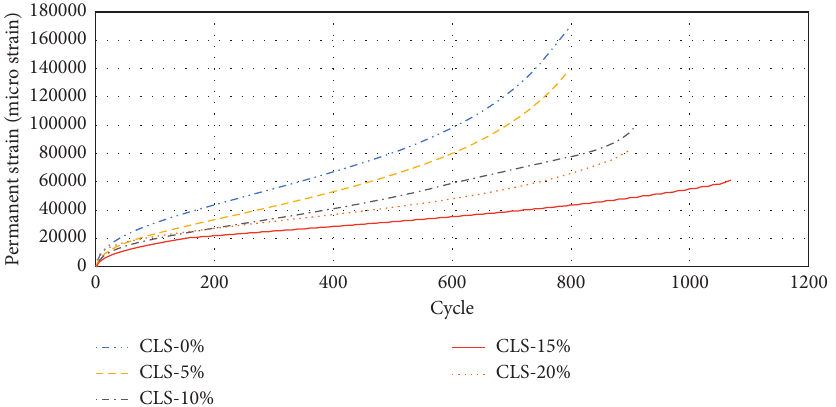
Figure 8: Creep curve for asphalt mixtures.